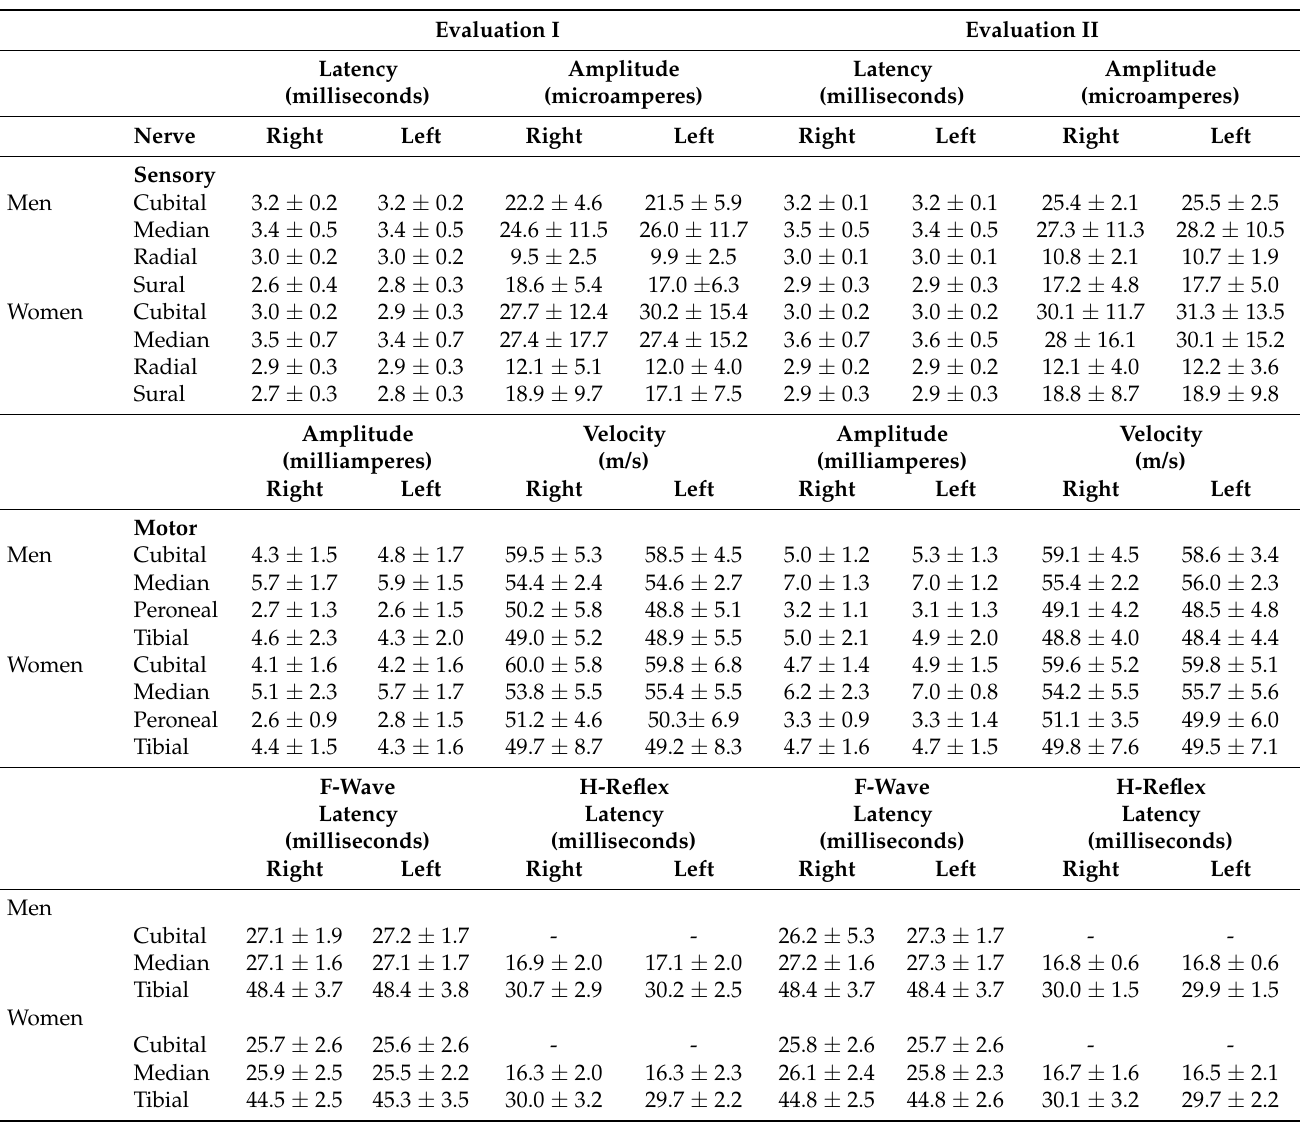
Table 4. Mean and standard deviation of the mean of the latency and amplitude of neuro-conduction tests, and the latency of F wave and H reflex of 43 patients at the first evaluation and 40 patients at the second